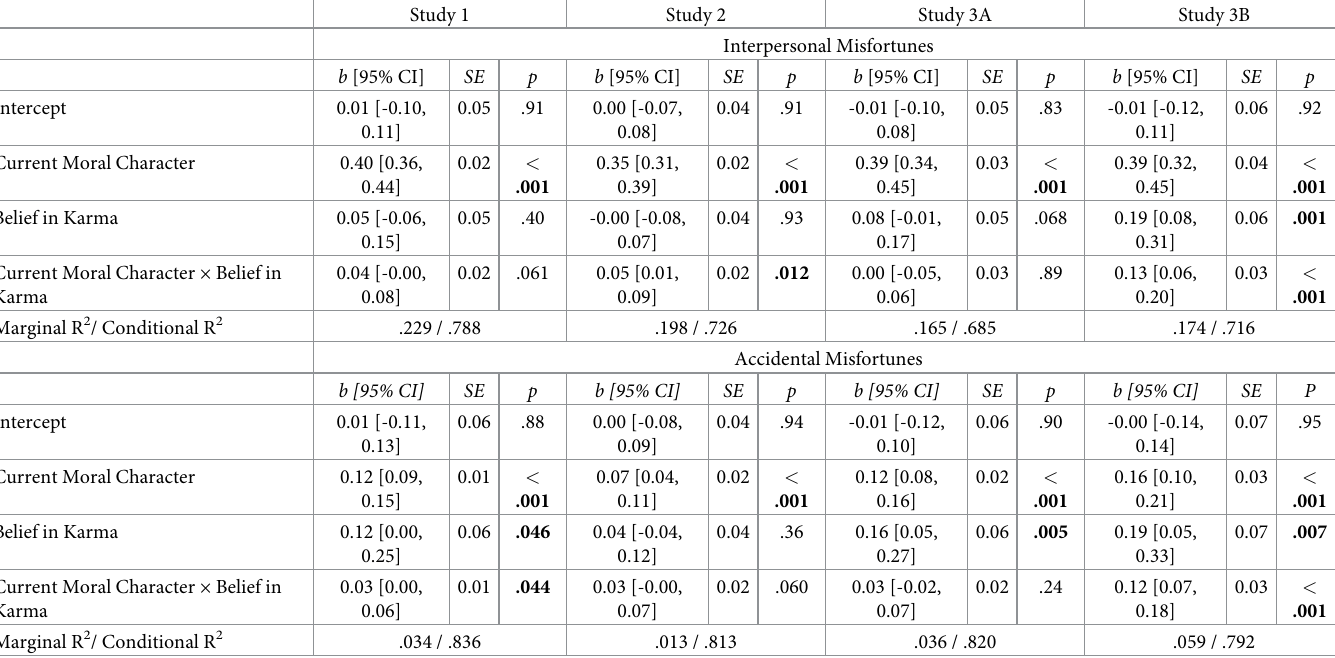
Table 4. Forecasts about future misfortunes (interpersonal and accidental) predicted by (a) inferences about current moral character, (b) individual differences in belief in Karma, and (c) the interaction between current moral character and belief in